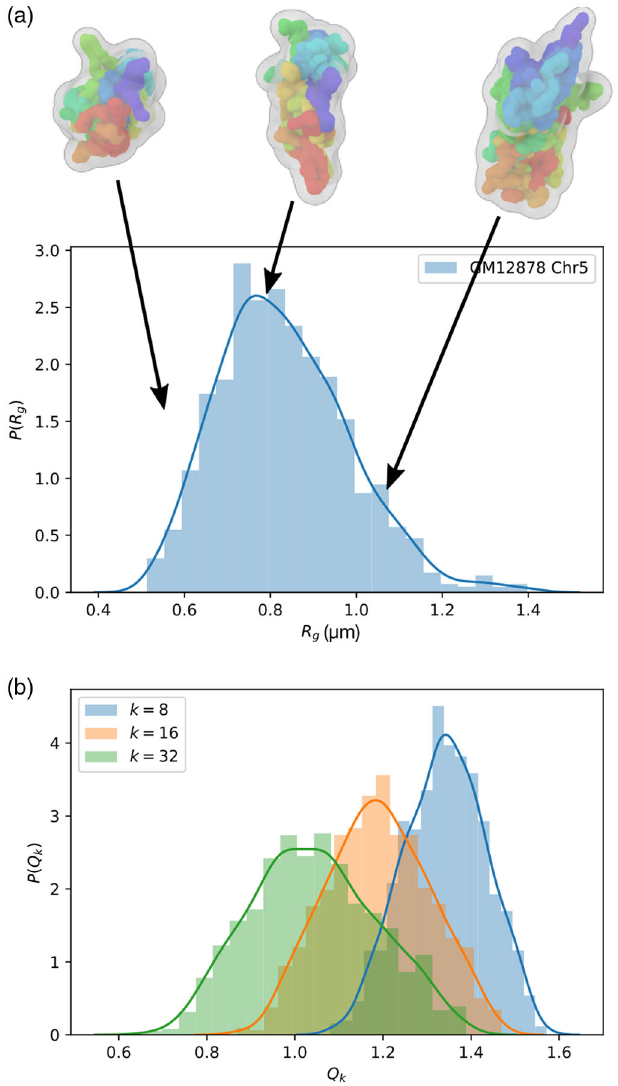
FIG. 6. (a) Distribution of the radius of gyration P ð R chromosome 5 from GM12878 cell type. Three structures whose R values are in the 0.15 quantile, 0.5 quantile, and 0.75 g quantile, respectively, are shown. (b) Distribution of the degree of mixing between A and B compartments P ð Q for chromosome 5.